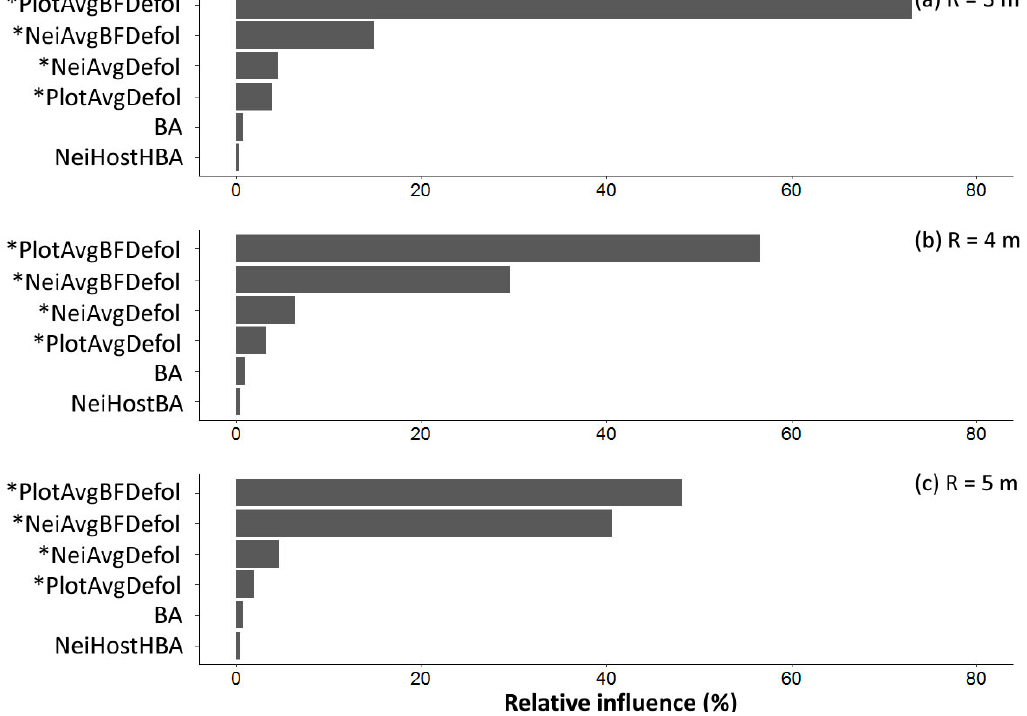
Figure 6. Relative influence (%) of the six most important predictor variables based on Gradient Boosting Machine analysis to predict current year defoliation of individual balsam fir trees (%) with neighborhood tree search radius (R) of ( a ) 3 m, ( b ) 4 m, or ( c ) 5 m. Predictor variable abbreviations are described in Table 4, and predictors marked with * were highly correlated with each other (correlation coefficient r ≥ 0.7).